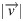
Simulations of seven patterns of perceived hand structure obtained by varying parameters of localization errors.The initial parameters, extracted from our real data, are reported in the top-left table (|v→|: magnitude of the average error vector; |r→|: angle consistency; θ: most frequent error direction). The perceived hand structure of Simulation 1 (top-left plot, red map) is obtained by multiplying the initial parameters of each landmark and adding inter-individual, -landmark and -trial noise (see S1 File). The resulting perceived hand structure is characterized by an underestimation of the mean finger length (length estimation ratio, ER: perceived / actual mean finger length), and an overestimation of the hand width (width ER: perceived / actual hand width). The error vectors of a representative subject are plotted inside the dashed frame. Simulation 2, 3, 4, 5, 6, and 7 are obtained by varying—of a similar intensity—one or more of the initial parameters (see S1 File). Similar (simulations 1 and 2; 3 and 4; 1 and 5; 6 and 7) and different perceived hand structures, in terms of mean finger length ER (1 and 3, 4; 2 and 3, 4) and hand width (1 and 6, 7; 5 and 6, 7), can be underlined by very different patterns of localization errors. ER distributions have been compared through parametric statistics (S1 File).